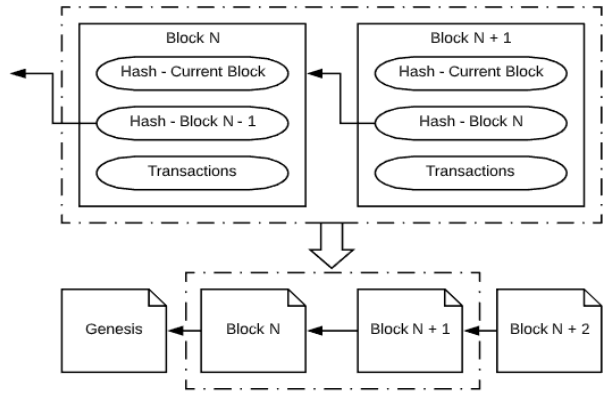
Figure 4. The chain data structure of blockchain.